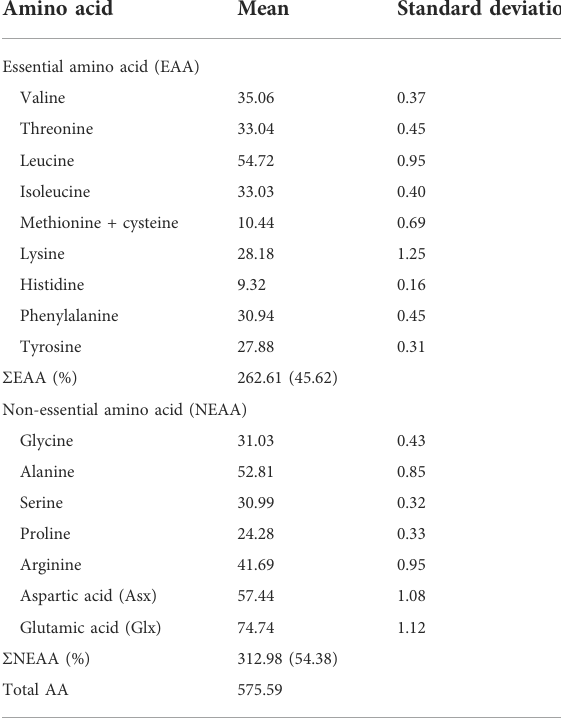
TABLE 3 Amino acid composition of the unaxenic cyanobacterium Synechococcus sp. UCP002 isolated from the Peruvian Amazon Basin region (mg.g − 1 of